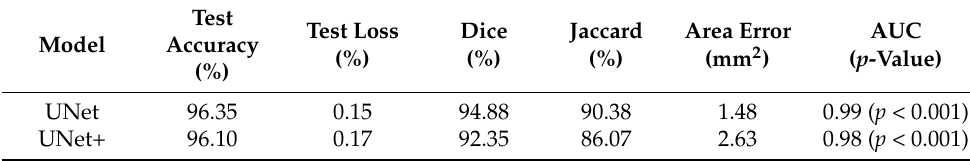
Figure 13. Comparison of results by two segmentation models; ( a ): Original CXR images, ( b ): Ground truth masks, ( c ): Masks generated by UNet model, ( d ): Masks generated by UNet+ model. Table 1. Comparative performance of UNet and UNet+ model.